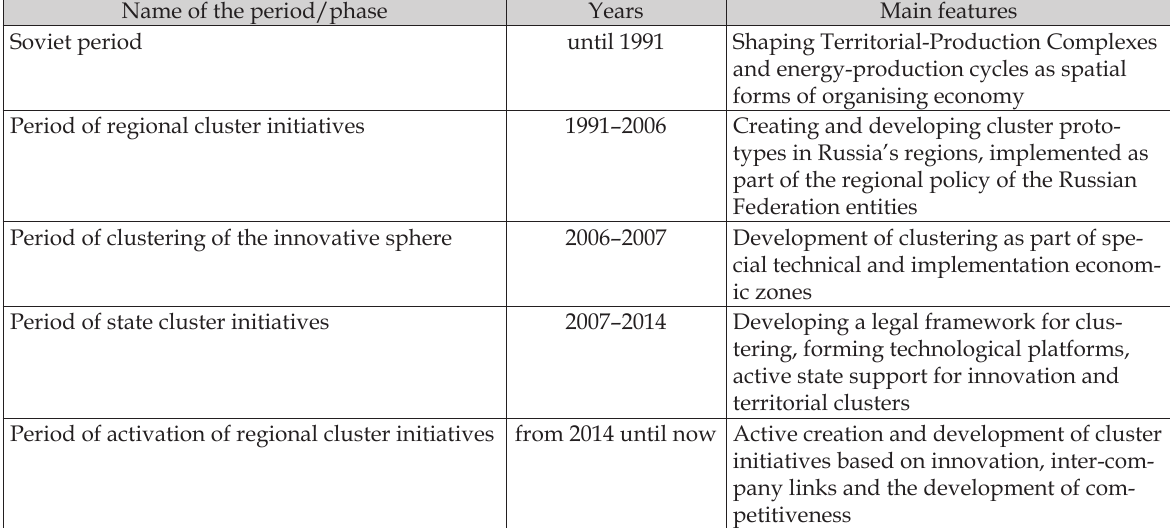
Table 1. Stages of shaping cluster policy in